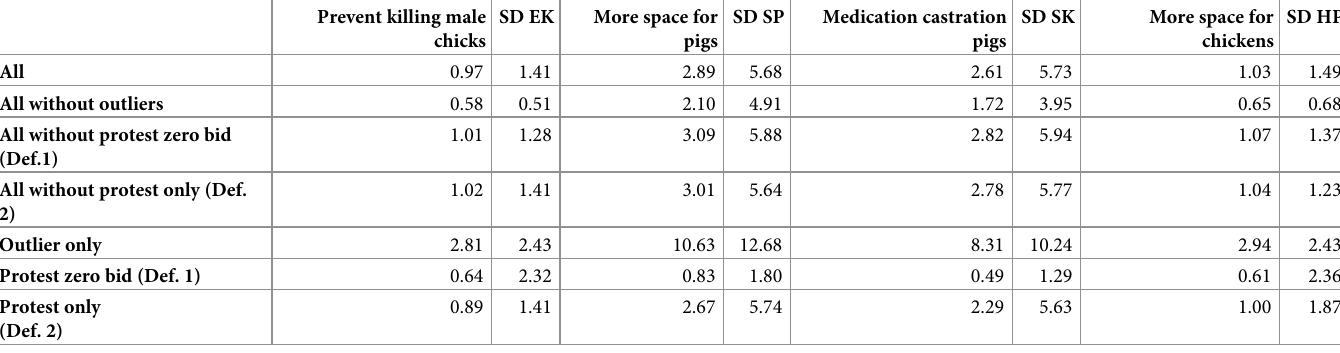
Table 5. Mean WTP in Euro for different groups.